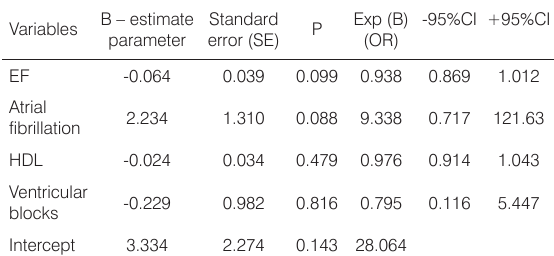
Table 4. Results of multivariate regression